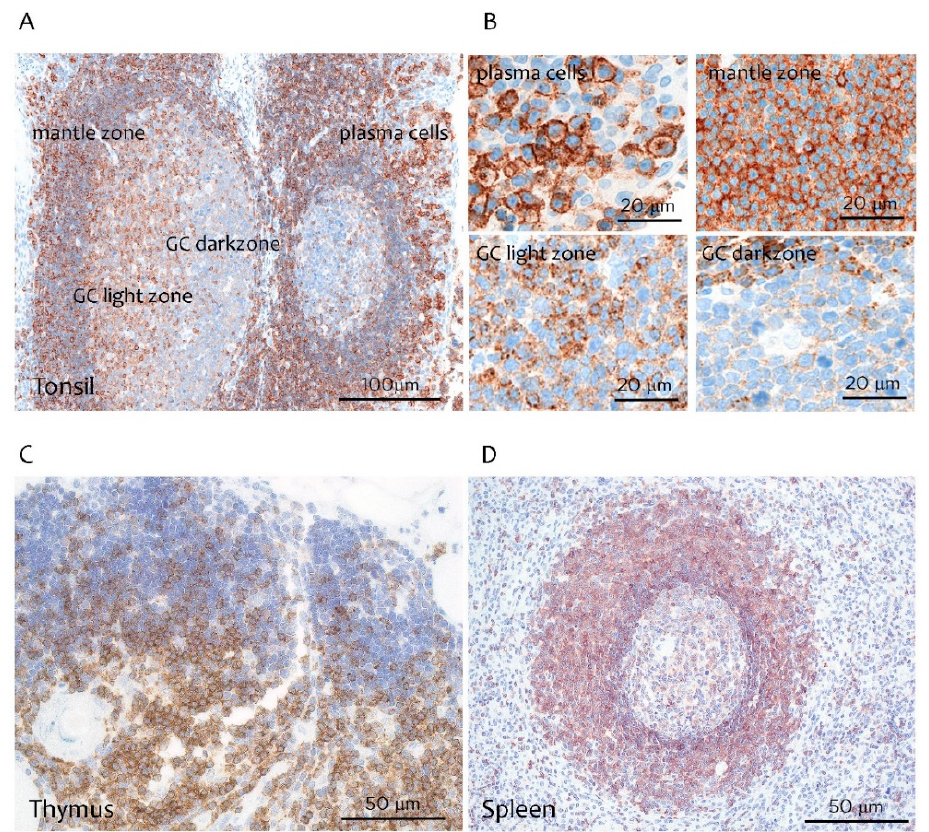
Figure 1. Expression of CD229 on normal lymphoid tissues. ( A ) Single immunoperoxidase labeling with mAb (clone PIZCU426A) against CD229 in human tonsil (magnifications: 20 × , scale bar 100 µ m). ( B ) Higher magnification of tonsil subepithelial area, mantle zone, GC light zone and GC dark zone (magnifications: 63 × , scale bar 20 µ m). CD229 staining in Thymus ( C ) and spleen ( D ) (magnifications 40 × , scale bar 50 µ m).